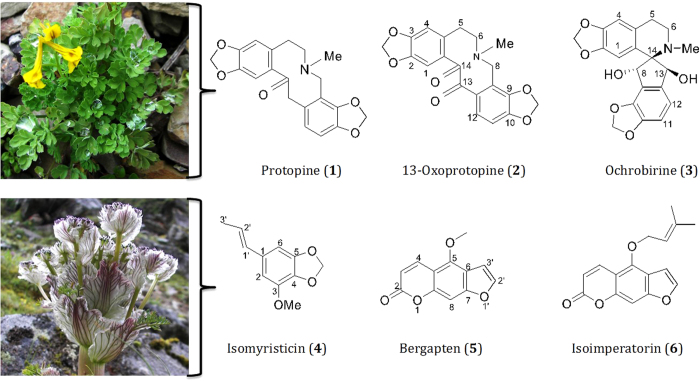
Structures of the compounds (1–6) isolated and screened for their anthelmintic activities.(A) Protopine (1), 13-Oxoprotopine (2) and ochrobirine (3) were isolated from Corydalis crispa14. (B) Isomyristicin (4), bergapten (5) and isoimperatorin (6) were isolated from Pleurospermum amabile15.